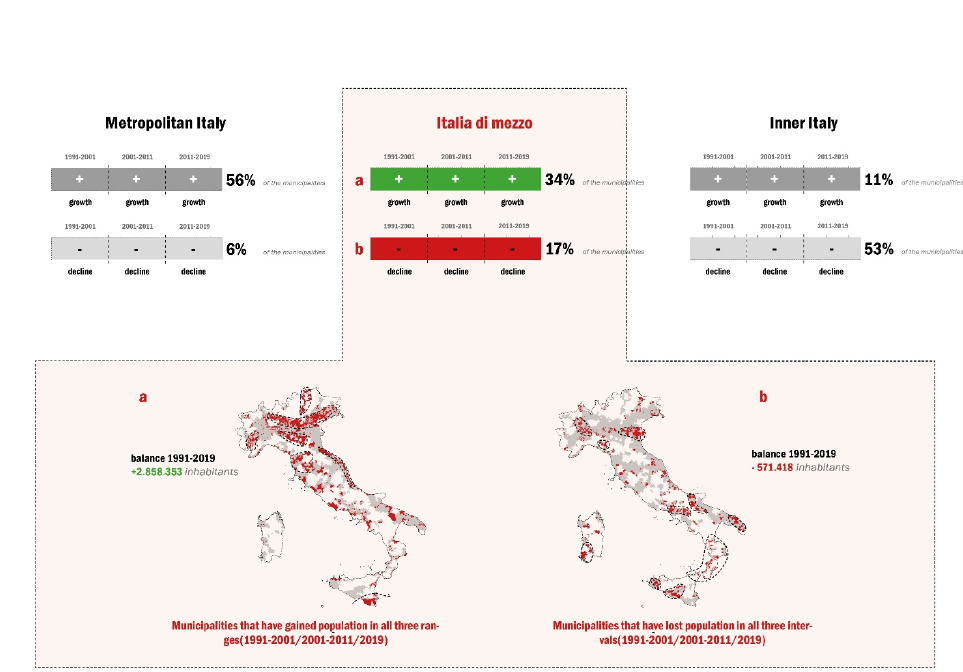
Figure 7: In many of its parts Italy is entering contraction processes after experiencing